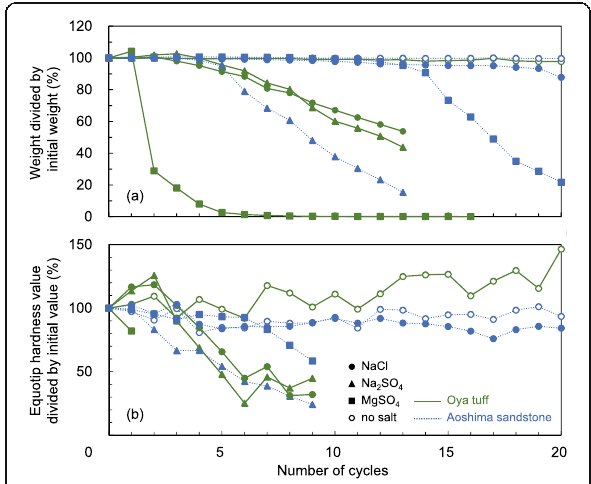
Fig. 7 Weight ( a ) and Equotip rebound value ( b ) measured during the continuous wetting/drying experiment. The solid line represents the results for Oya tuff, and the dotted line represents those for Aoshima sandstone. The symbols correspond to the following combinations: filled circles, NaCl; triangles, Na 2 SO 4 ; squares, MgSO 4 ; open circles, no salt (distilled